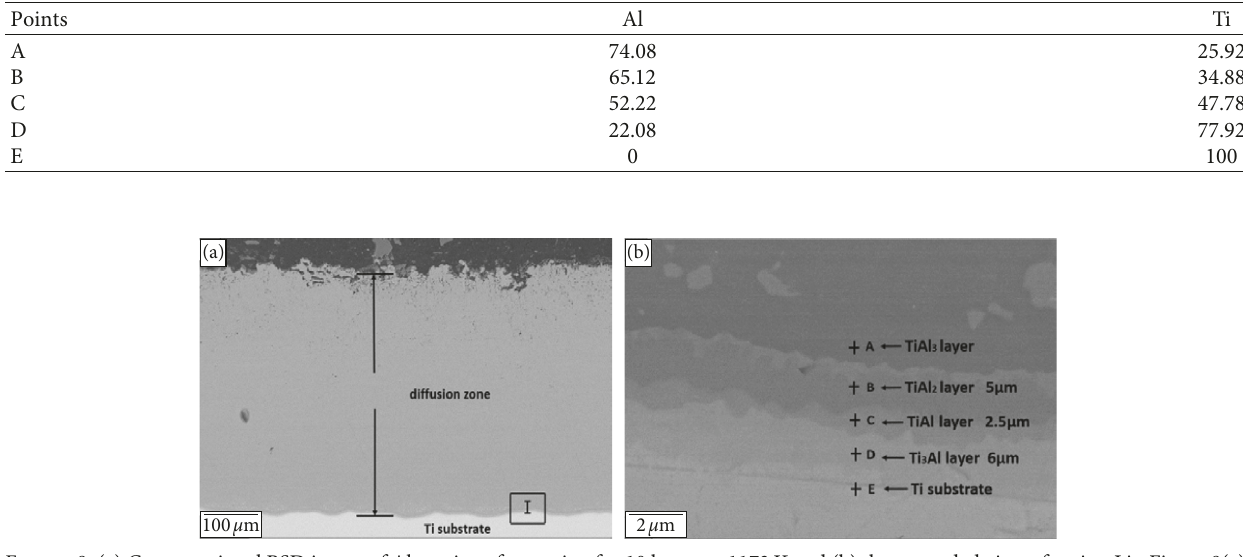
Figure 8: (a) Cross-sectional BSD image of Al coating after testing for 10 hours at 1173K and (b) the expanded view of region I in Figure 8(a).